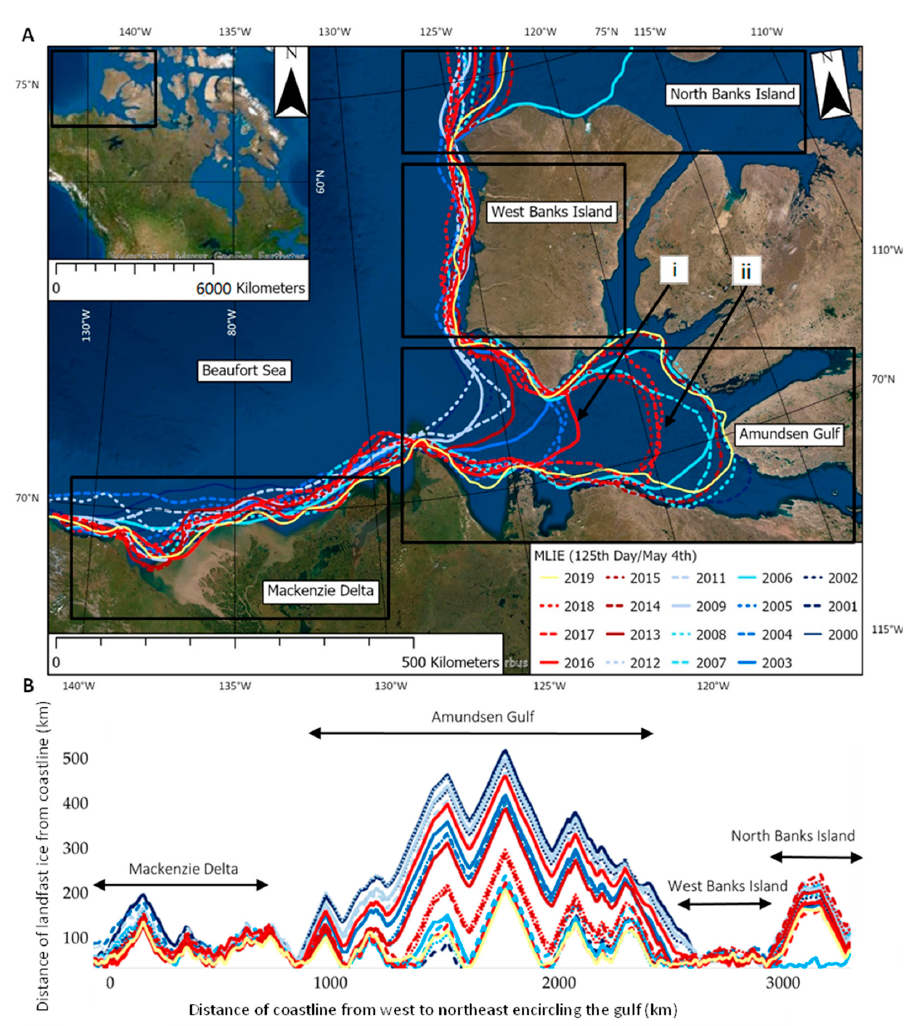
Figure 4. ( A ) The visual MLIE position per 4th of May from 2000 to 2019 across the study area and four regions outlined in black boxes. Both (i) and (ii) represent two of the four clusters discussed. ( B ) The distance in km of MLIE perpendicular from the coastline across the study area and four regions outlined with black